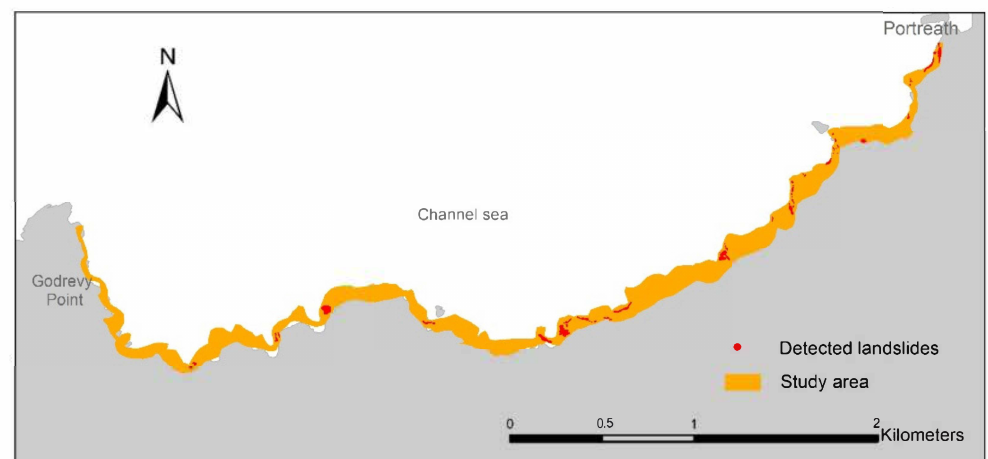
Figure 2. The boundary of the study area in which landslides occurred in 2008–2014 is